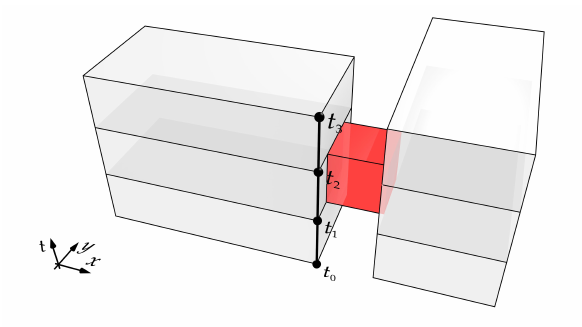
Figure 4: A 2D+time model generated using extrusion. The red volume represents the footprint of a corridor that existed between times t 1 and t 2 . The left and right building footprints were thus extruded along [ t 0 , t 3 ] and the corridor footprint along [ t 1 , t 2 ]